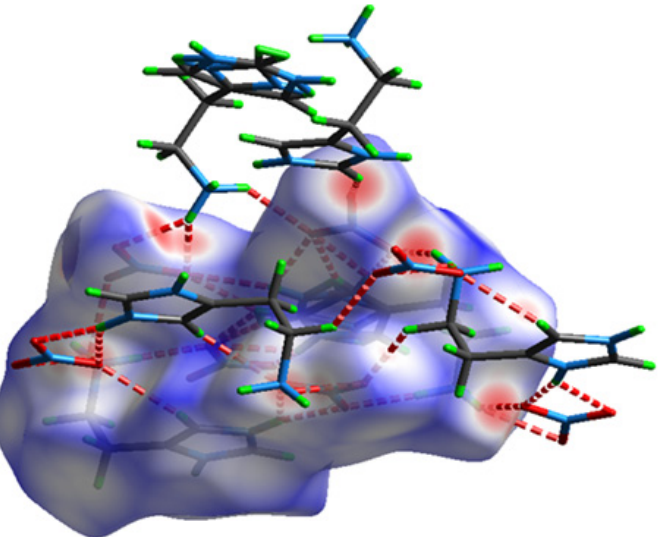
Figure 3. The Hirshfeld surface of HTN mapped in d norm mode ( − 0.03–1.113).